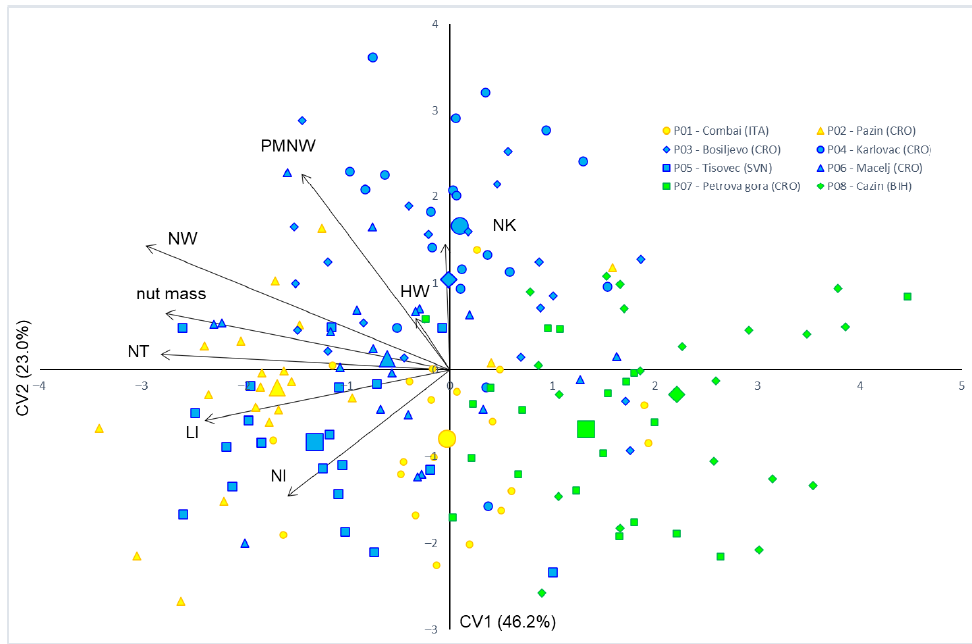
Figure 3. Discriminant analysis of eight sweet chestnut populations based on eight morphological traits that were the most useful for maximum discrimination between studied populations. Each individual tree is indicated by a small sign, while the population barycenters are represented by larger ones. The color of the signs is related to the biogeographical region and management type: yellow color — sub-Mediterranean high-forest populations; blue color — continental high-forest populations; and green color — continental coppice populations. Morphometric traits: nut width (NW); distance from nut base to the point of maximum nut width (PMNW); nut thickness (NT); hilum width (HW); number of kernels (NK); number of intrusions of the seed coat into the kernel (NI); length of the longest intrusion of the seed coat into the kernel (LI). Canonical discriminant variate (CV).